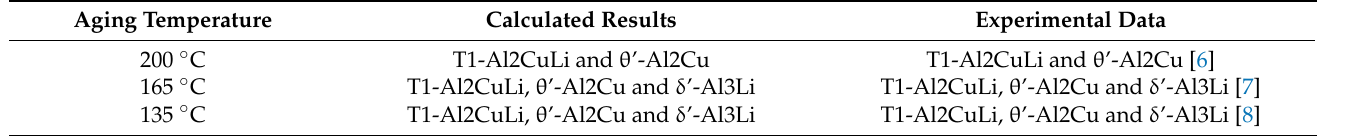
Figure 17. The kinetic curves of 2A97 alloy at 135 °C. Table 4. Comparison between the calculated results and experimental data.